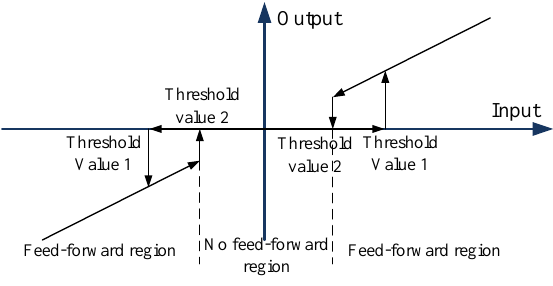
Figure 7. The dead zone with the hysteresis loop.